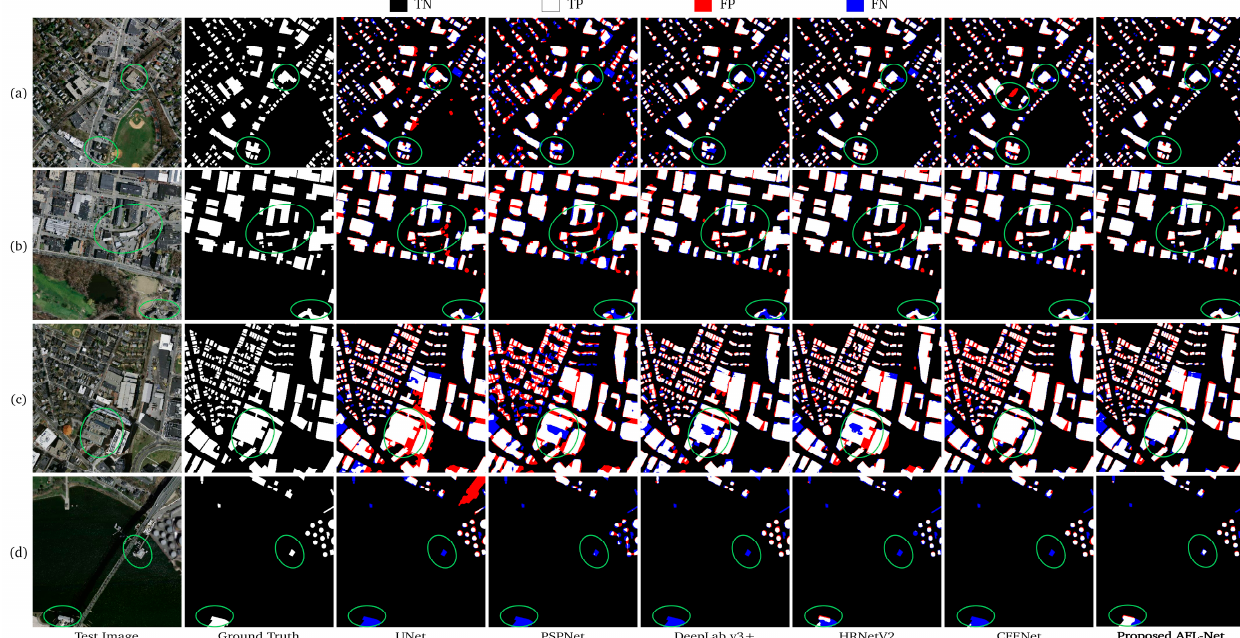
Figure 11. Sample building segmentation results from the selected models with the Massachusetts dataset (comparative experiment). sachusetts dataset (comparative